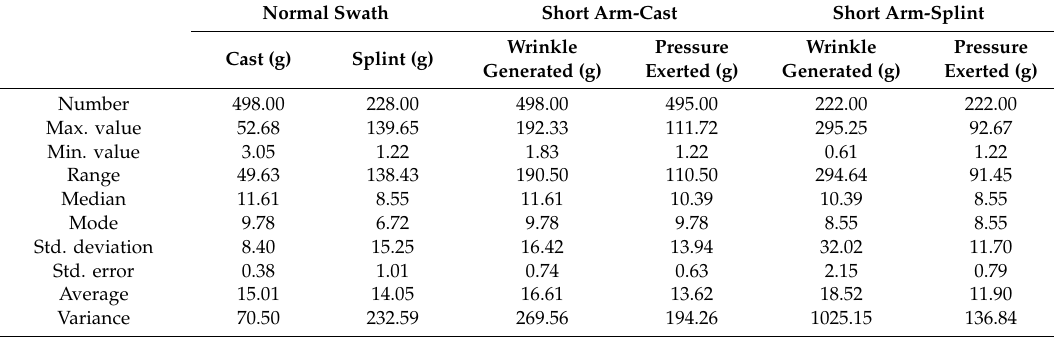
Table 1. Analysis of simulated experimental data using short arm-cast and short